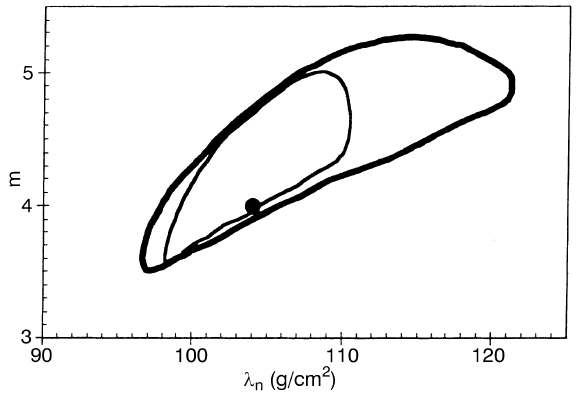
Fig. 1. Values of parameters m and (cid:107) n of the empirical expression given by Eq. (6) for the neutron-monitor response to solar neutrons. The calculations were made for the 24 May 1990 solar-neutron event. The point corresponds to the best fit